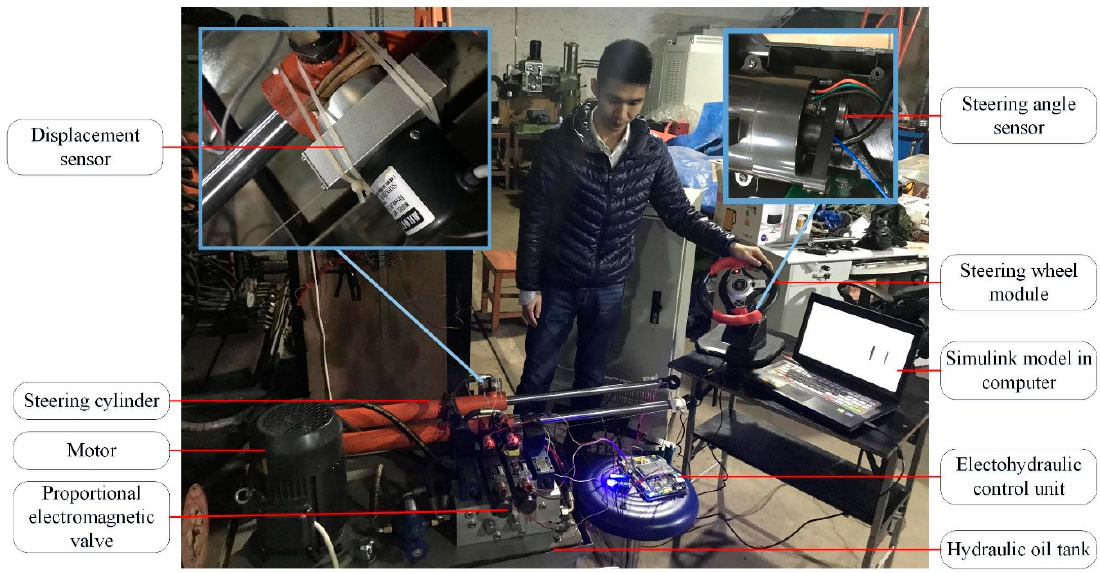
Figure 28. The experimental platform.